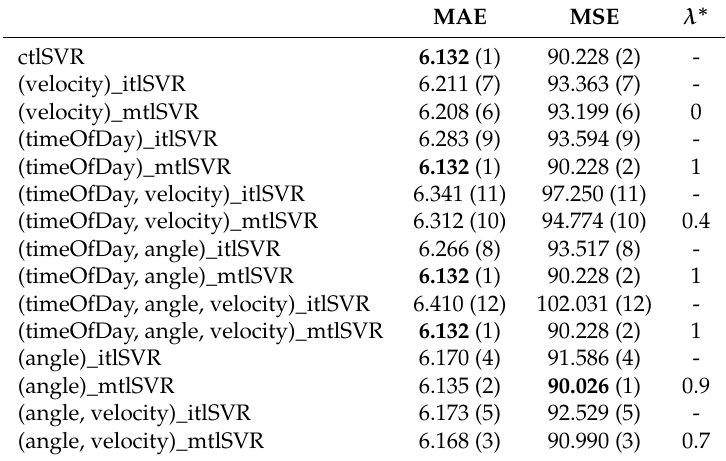
Table 5. Test MAEs (left), MSEs scores (center), and optimal mixing λ ∗ (right) of the Sotavento wind energy models considered. The best model errors are shown in